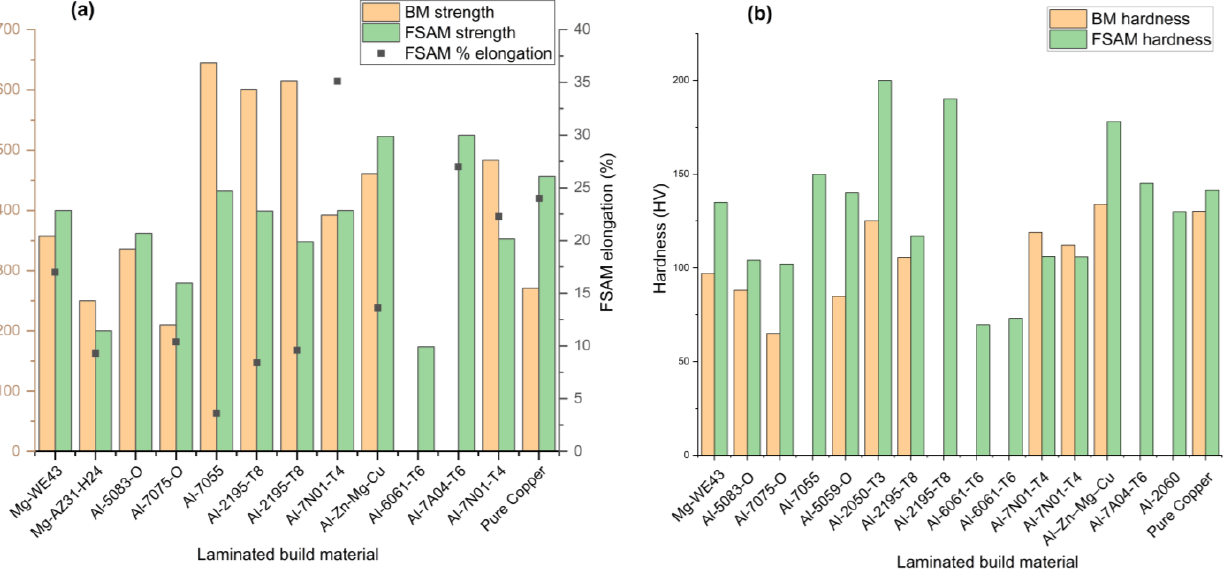
Figure 16. Overall mechanical properties summary of identical material laminates accomplished by researchers (discussed above): ( a ) maximum strength and corresponding elongation (%); ( b ) maxi- mum microhardness.